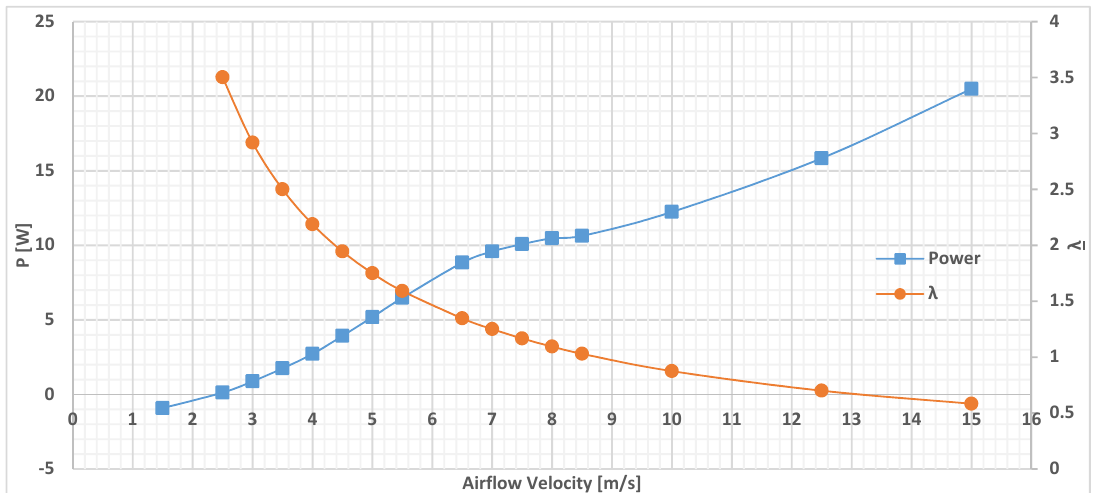
Figure 14. Figure 8. Torque and λ vs Airflow Velocity for machigua seed.